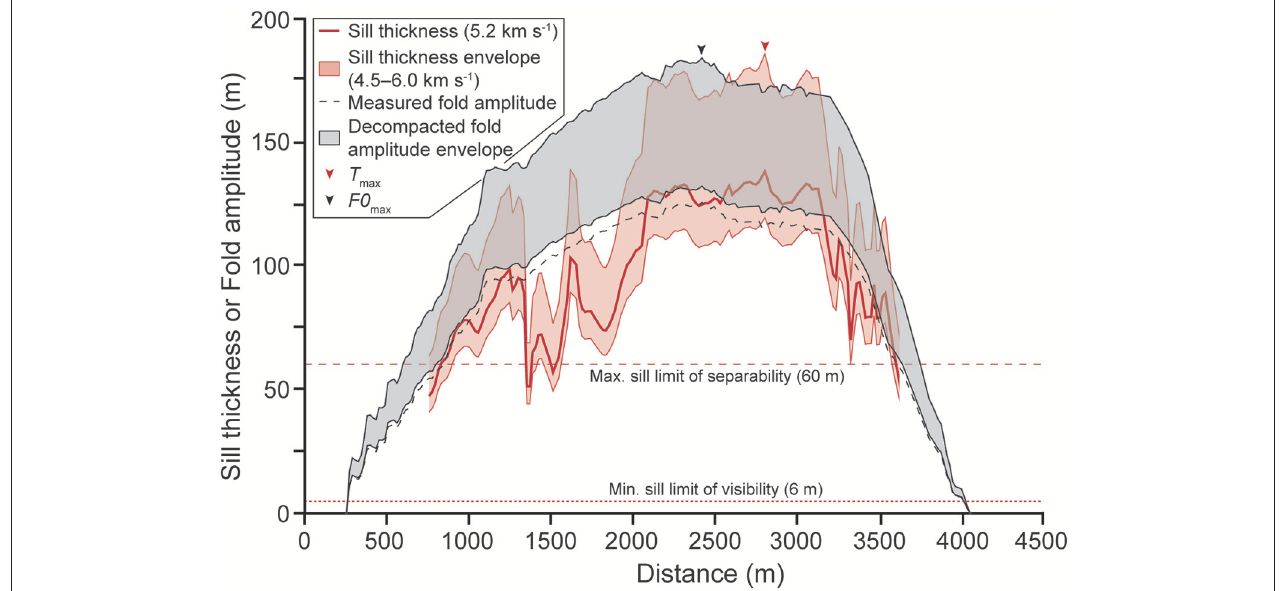
FIGURE 9 | Plot of fold amplitude and sill thickness across the seismic line in Figure 5C , highlighting how the measured fold shape and amplitude changes if the seismic data is decompacted and